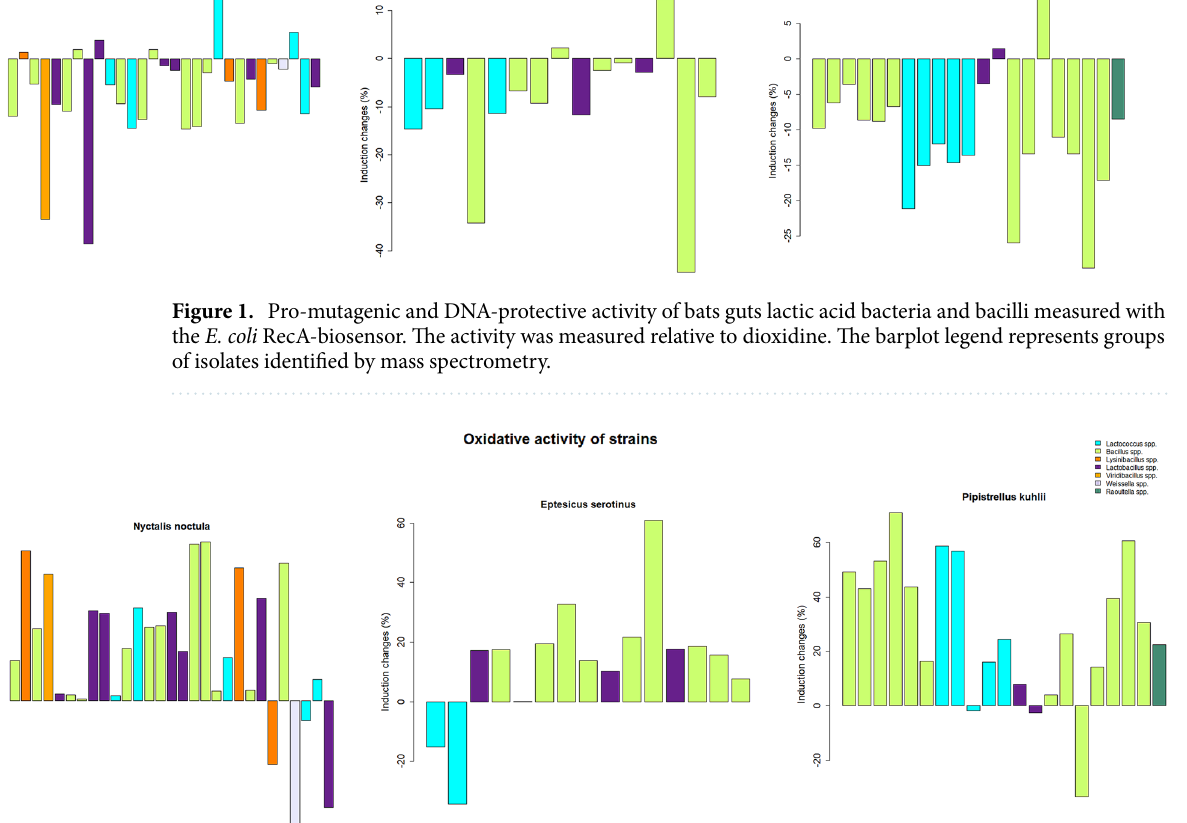
Figure 2. Prooxidant and antioxidant activity of bats guts lactic acid bacteria and bacilli measured with the E. coli Kat-biosensor. The activity was measured relative to peroxide. The barplot legend represents groups of isolates identified by mass spectrometry and isolated from individual